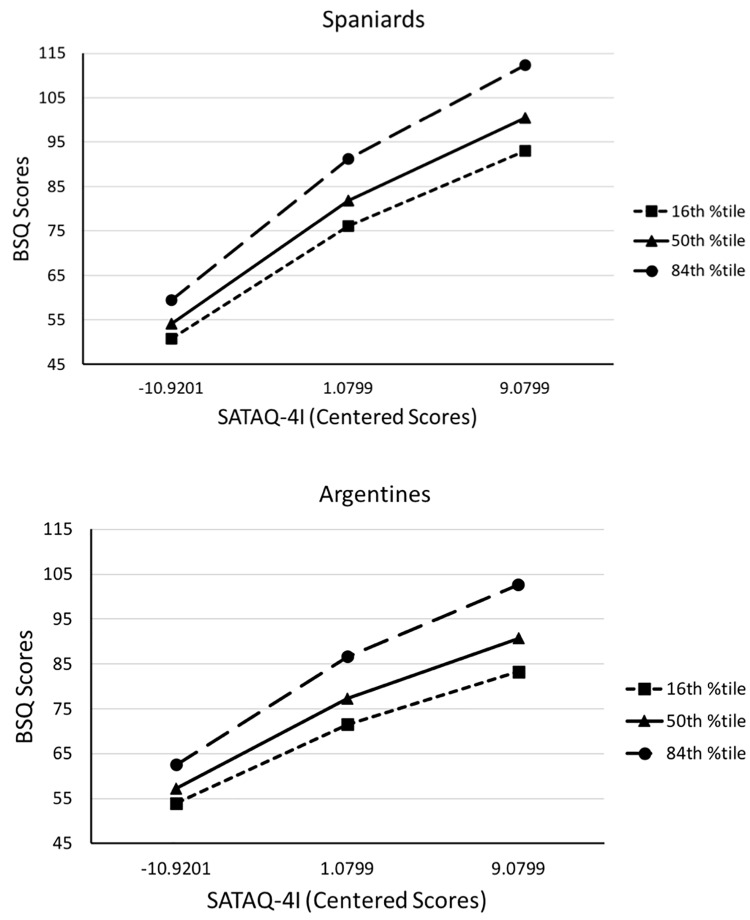
Visual representation of the association between internalization (SATAQ-AI centered scores) and Body Dissatisfaction (BSQ scores) at each of the probed BMI values in the Spanish and Argentine samples.